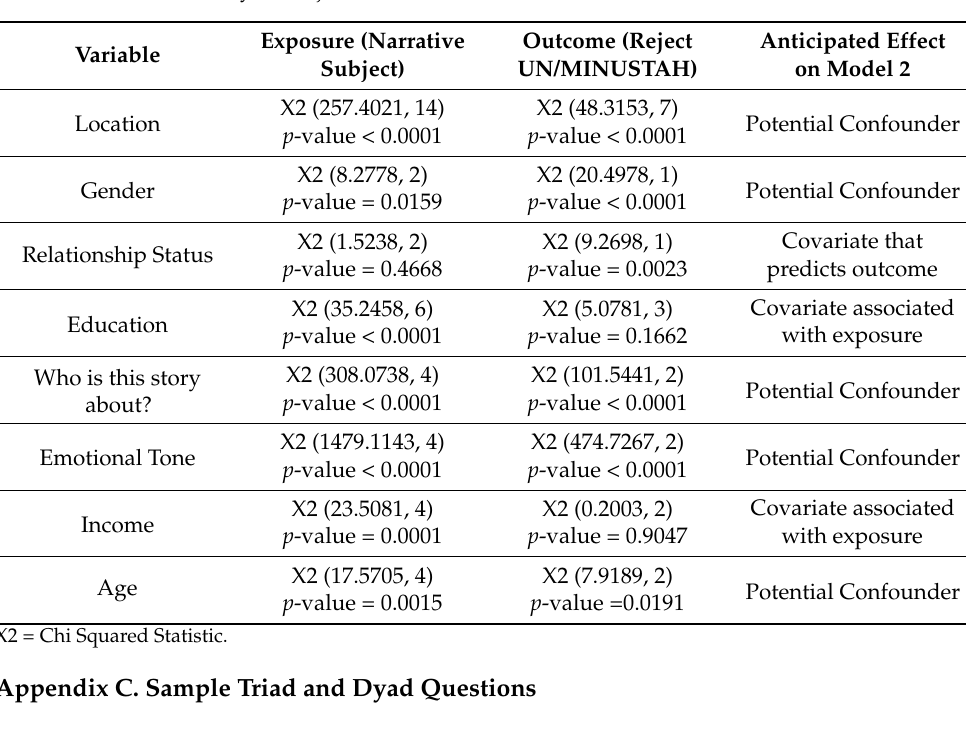
Figure A1. Example triad